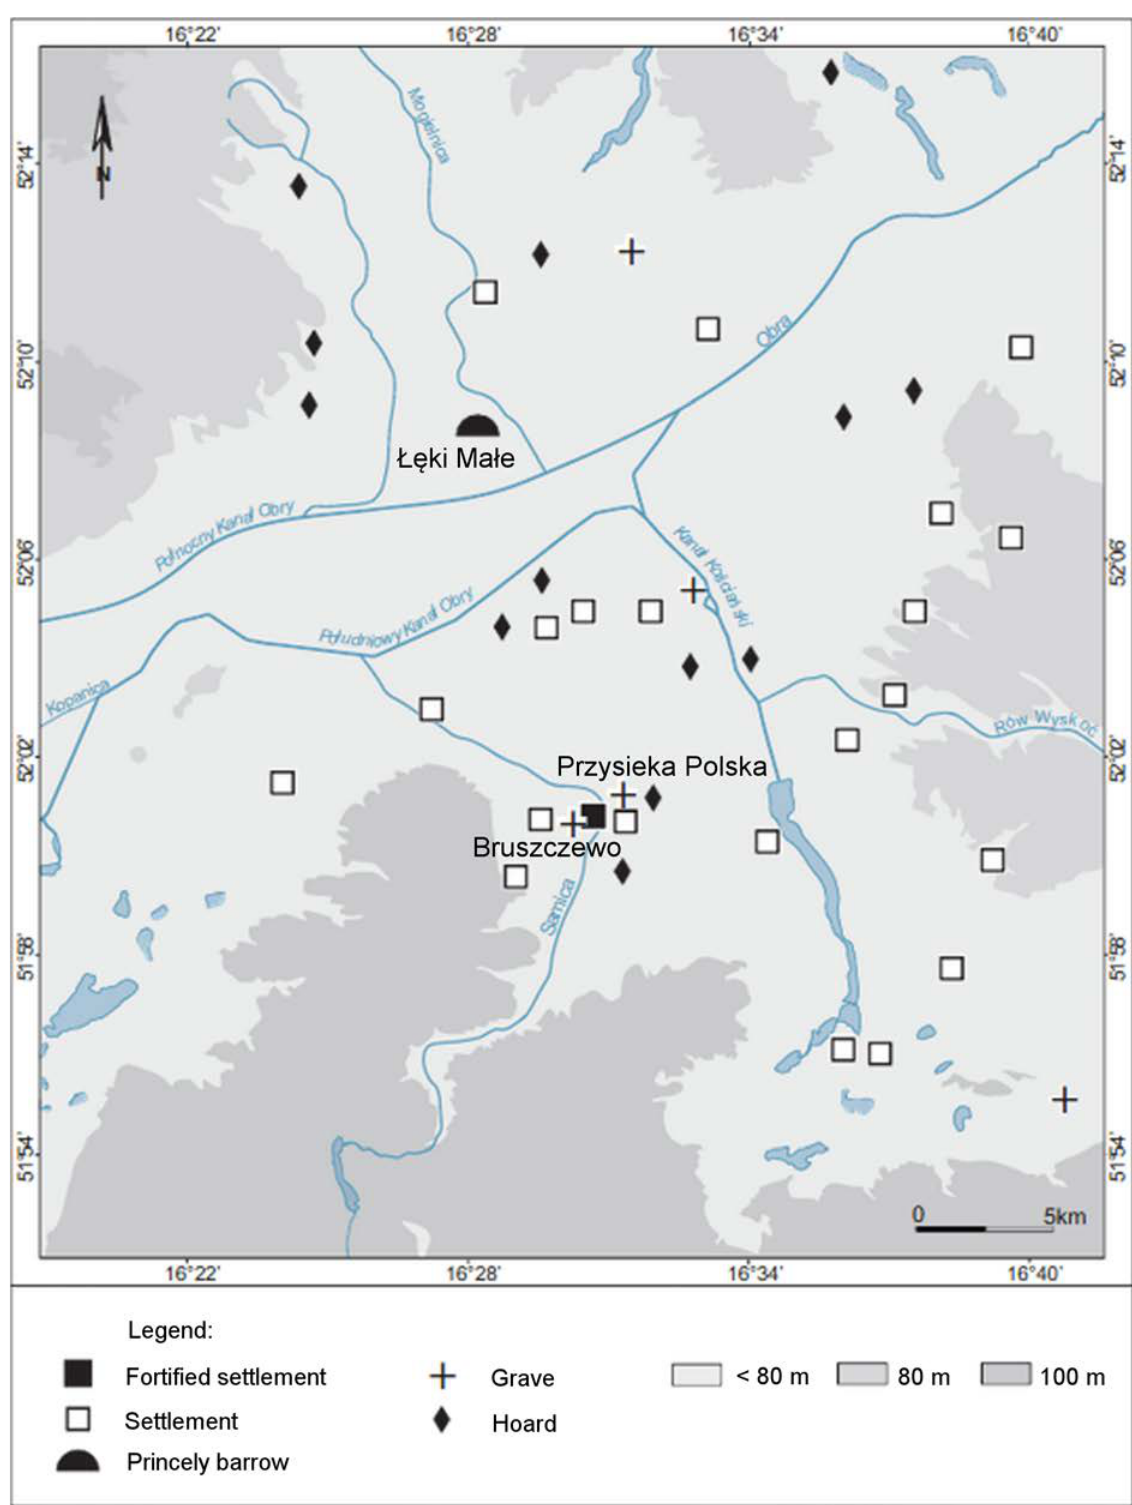
Figure 1. Kościan region with Early Bronze Age archaeological sites (adapted from Müller & Czebreszuk 2010: Abb.